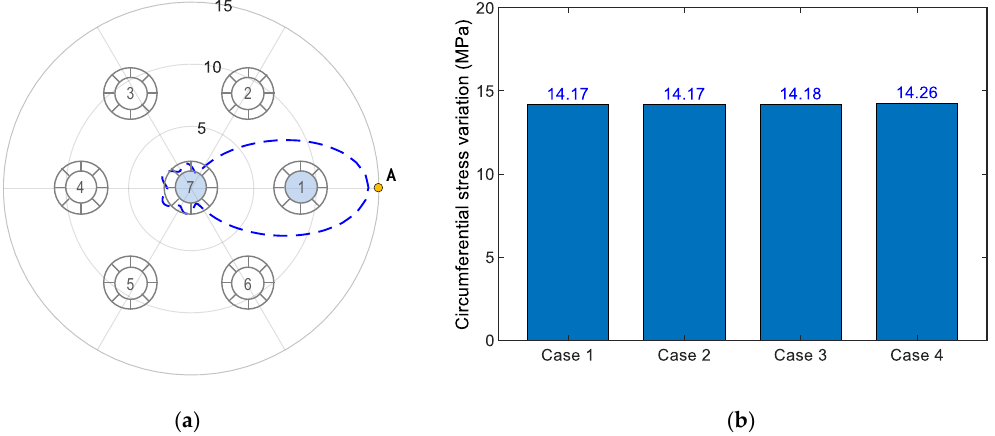
Figure A1. The effect of boundary condition on circumferential stress variation. ( a ) Circumferential stress variation in Case 1 and ( b ) comparison of circumferential stress variation.